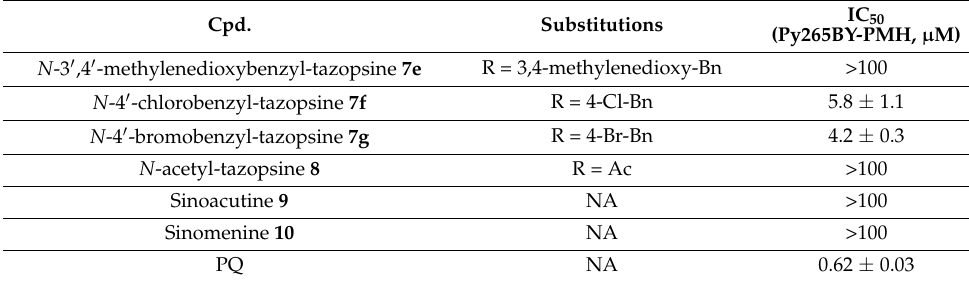
Table 2. Cont. Cpd.